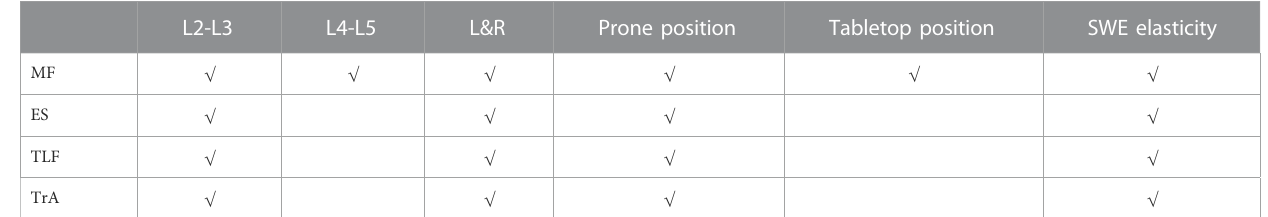
TABLE 2 Data collection sites and the patients ’ positions.